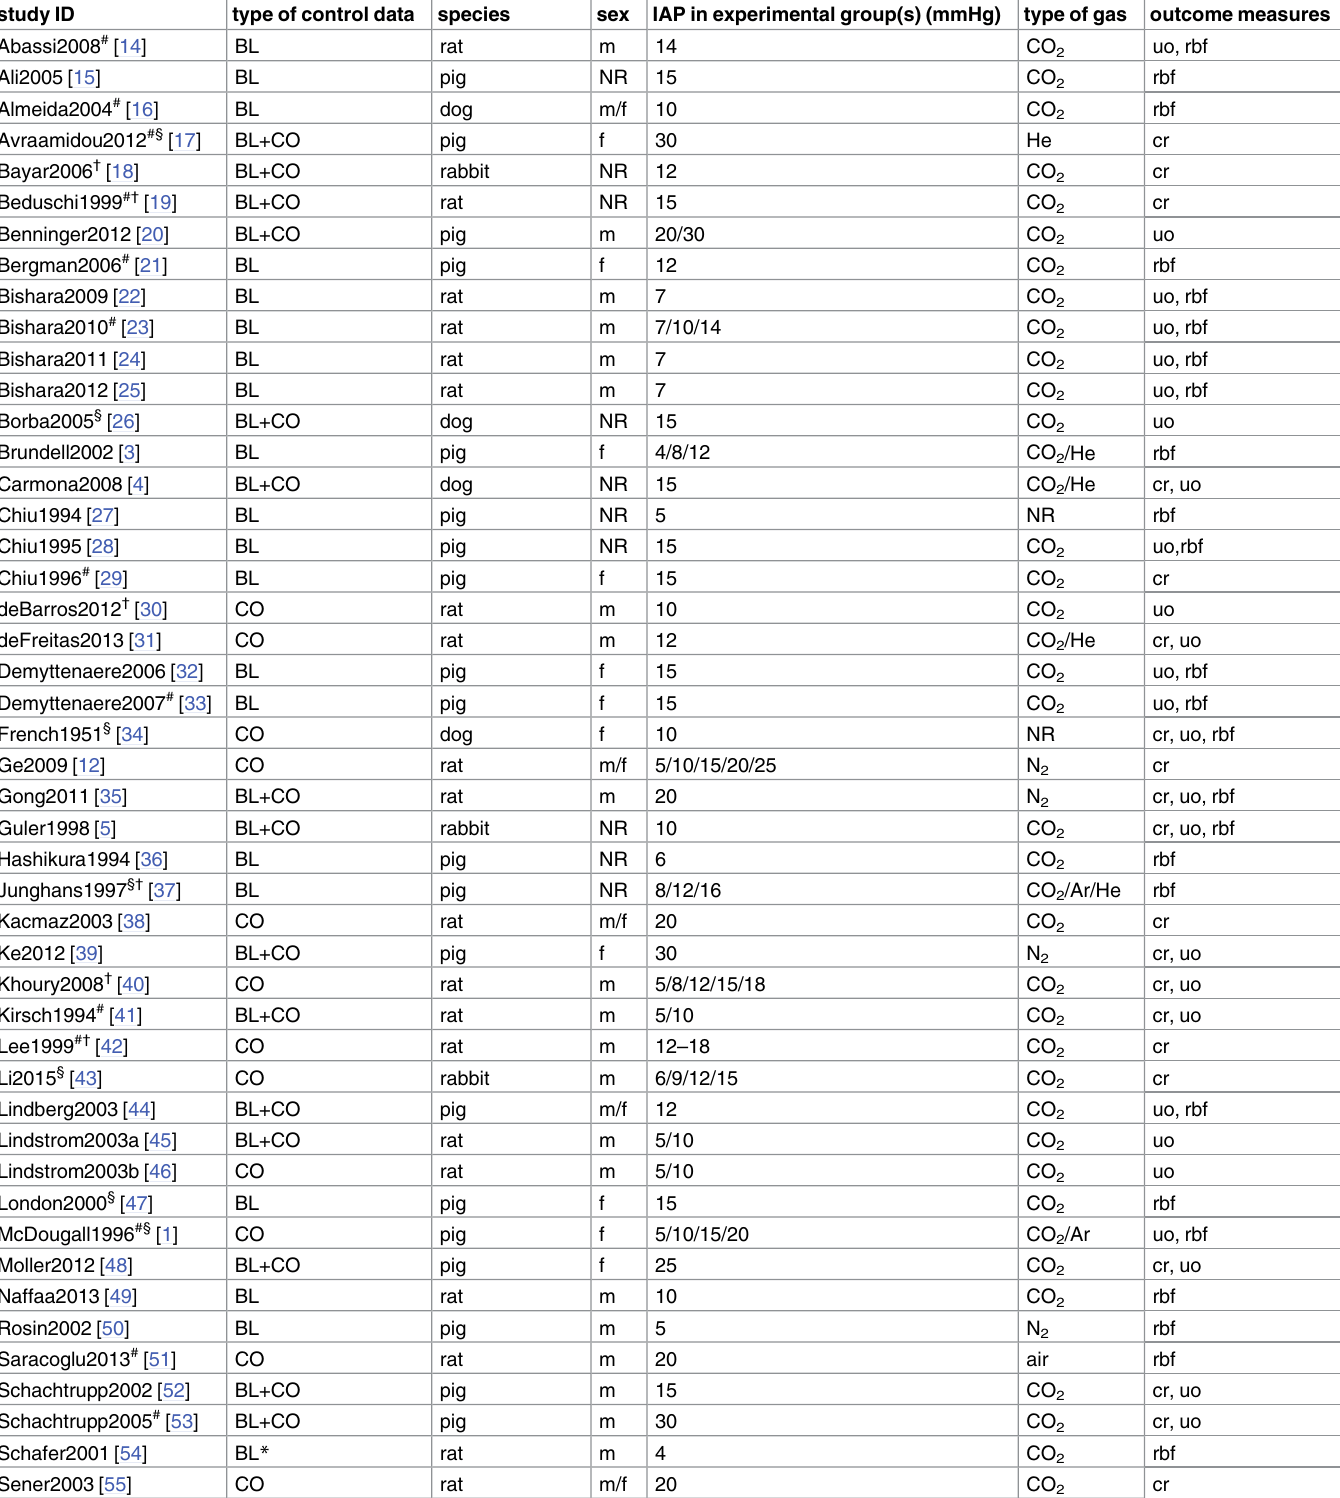
Table 1. Primary study